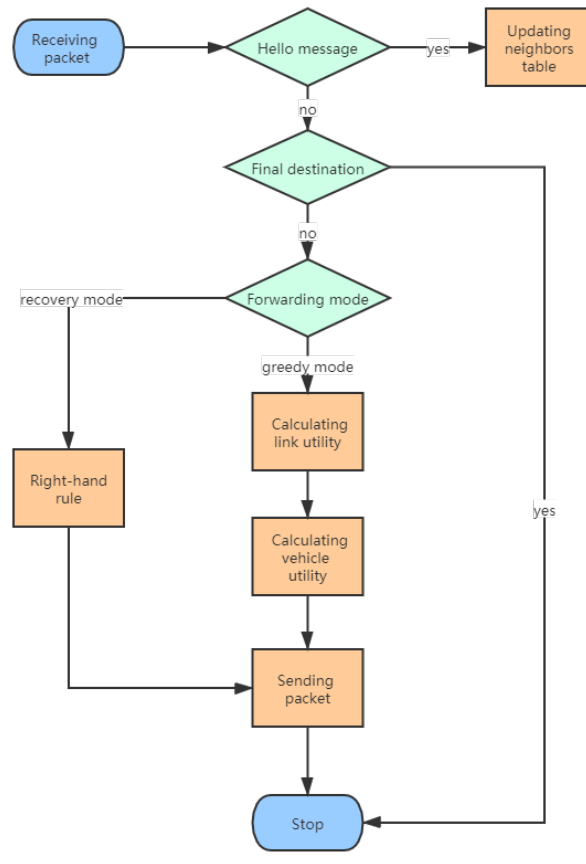
Figure 8. Routing